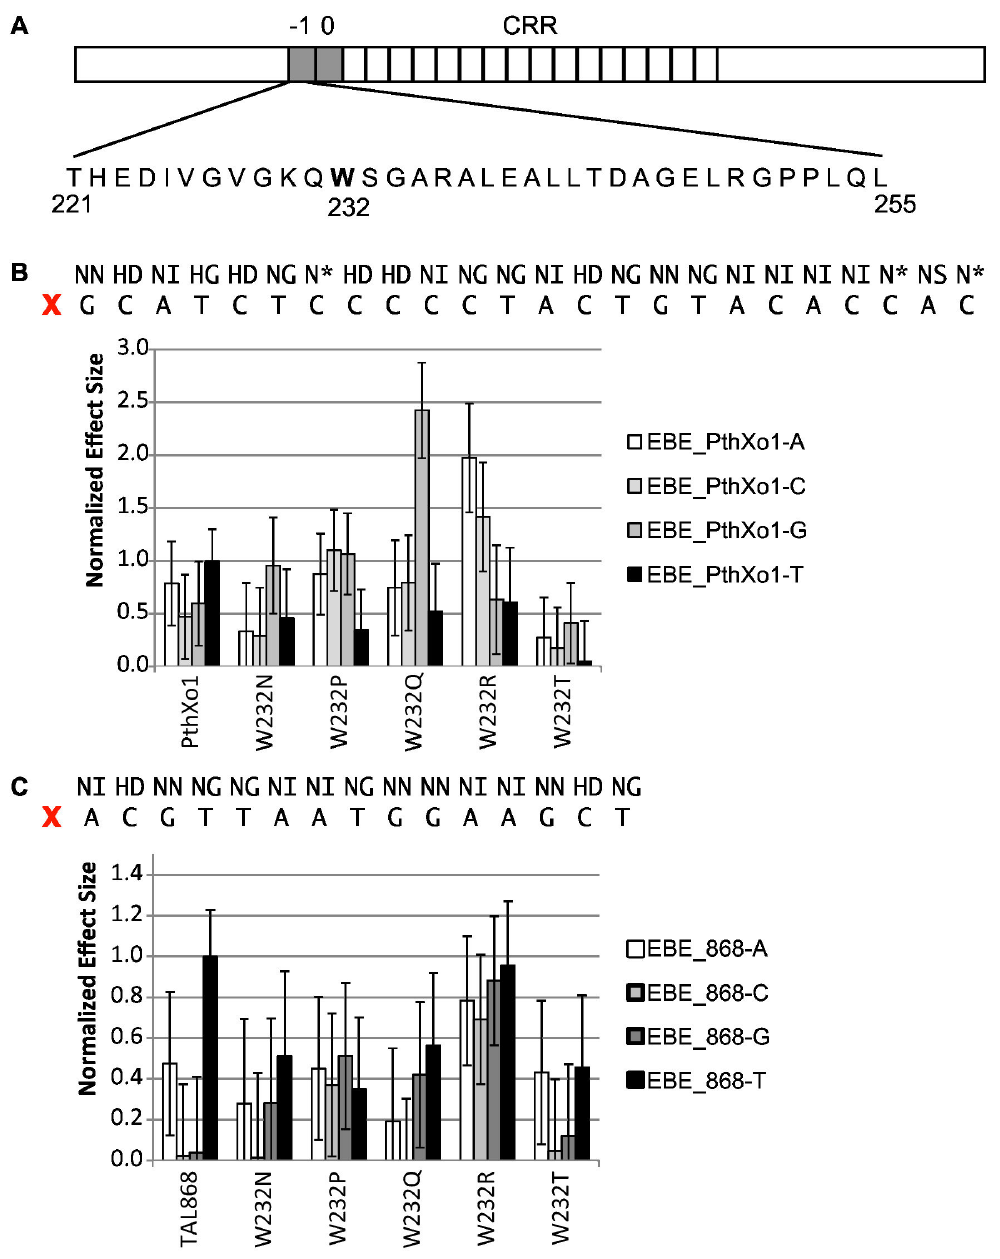
Figure 2. Activity of TAL effectors with selected single amino acid substitutions for W232 on targets with A, C, G, or T at the 0 th position. A. Schematic of a TAL effector with the -1 st and 0 th repeats and the central repeat region (CRR) labeled. The amino acid sequence of the -1 st repeat is shown below; W232 is shown in bold. B. Effects of PthXo1 W232 substitution and target combinations (treatment) on activity. Shown at top are the PthXo1 RVD and EBE sequences. X marks the 0 th position. Activity was measured in an Agrobacterium -mediated transient expression assay in Nicotiana benthamiana leaves, using a GUS reporter gene cloned downstream of a minimal promoter (see Materials and Methods) containing a PthXo1 EBE with the 0 th position thymine (EBE_PthXo1-T), or variants with adenine, cytosine, or guanine as base 0 (EBE_PthXo1-A, EBE_PthXo1-C, and EBE_PthXo1-G, and respectively). Treatment effects were estimated using a mixed linear model to account for variation due to experiment and replicate effects (see Materials and Methods). Effects were computed relative to the negative control EBE_PthXo1-T with no TAL effector and normalized to the effect of wild-type PthXo1 (W232) on EBE_PthXo1-T. Bars indicate one standard deviation. C. Effects of TAL868 W232 substitution and target combinations on activity, as in B. Shown at top are the TAL868 RVD and EBE sequences. X marks the 0 th position. doi: 10.1371/journal.pone.0082120.g002 PLOS ONE |